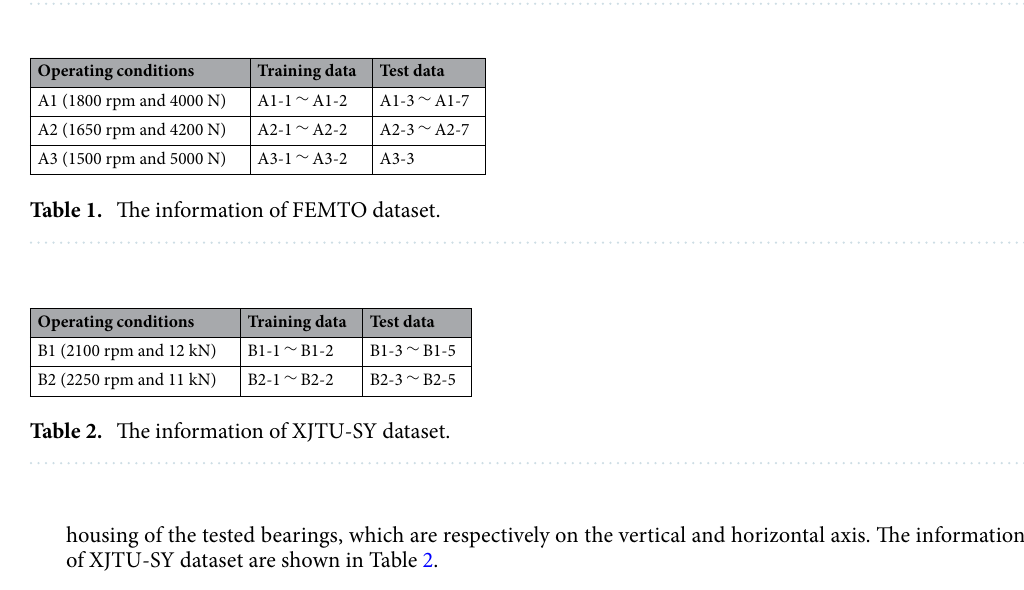
Figure 3. The schematic diagram of the process of the proposed model.